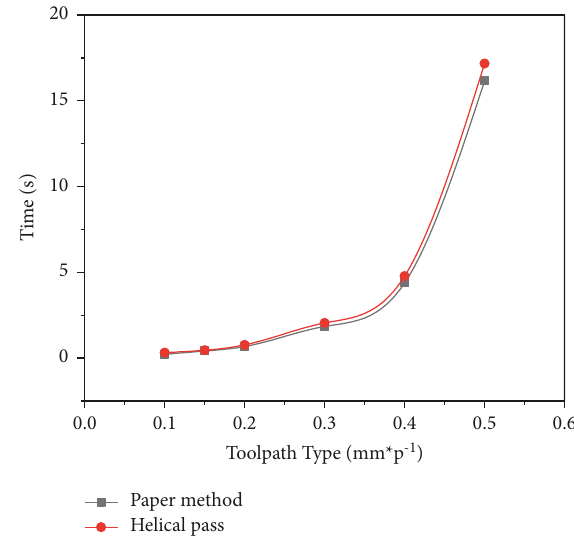
Figure 4: Comparison of processing path calculation efficiency (helical